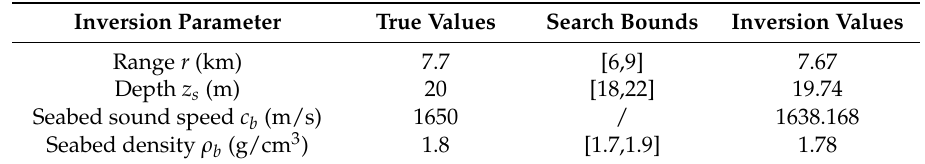
Table 1. Inversion parameter list. The search bounds, true values, and inversion values are